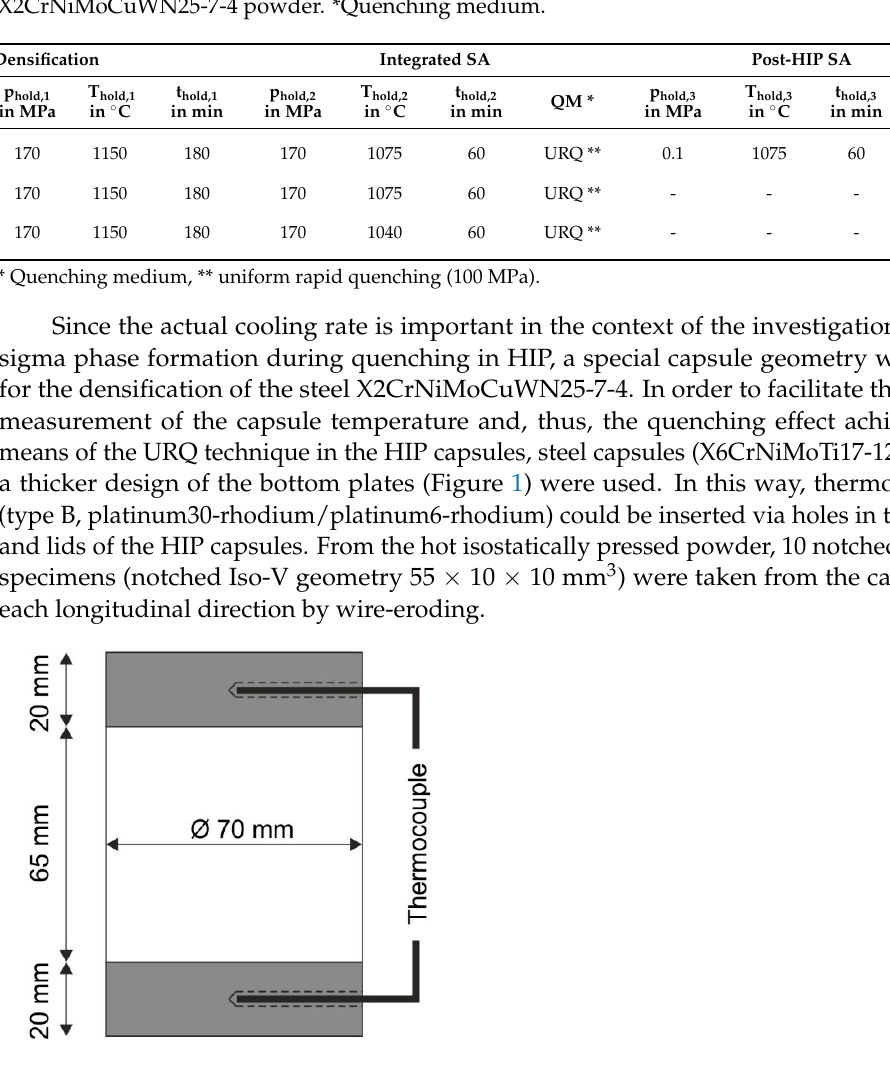
Table 2. Parameters used for the densification and solution annealing of the X2CrNiMoN22-5-3 and X2CrNiMoCuWN25-7-4 powder. *Quenching medium.